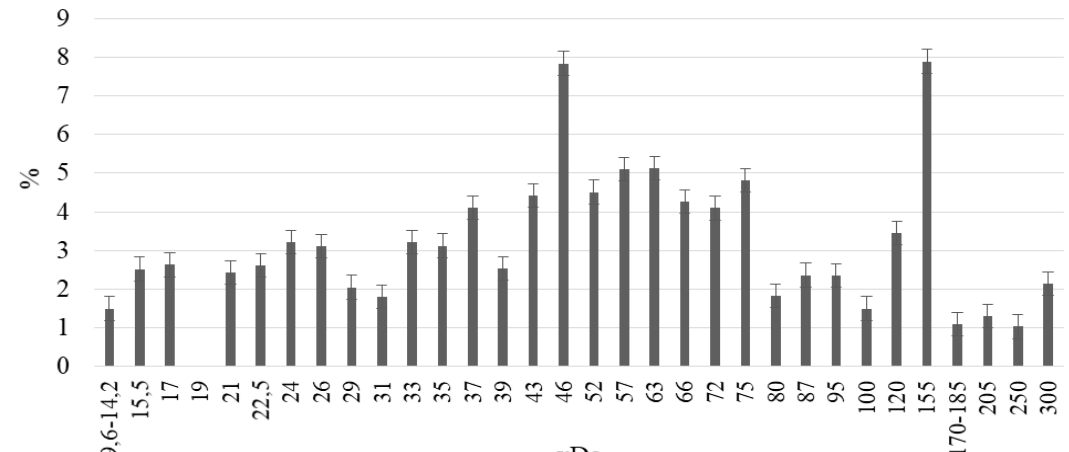
Fig. 3. Structural proteins of the apical membrane of the jejunum enterocytes of nine-month-old cattle fetus (M ± m; %; n =